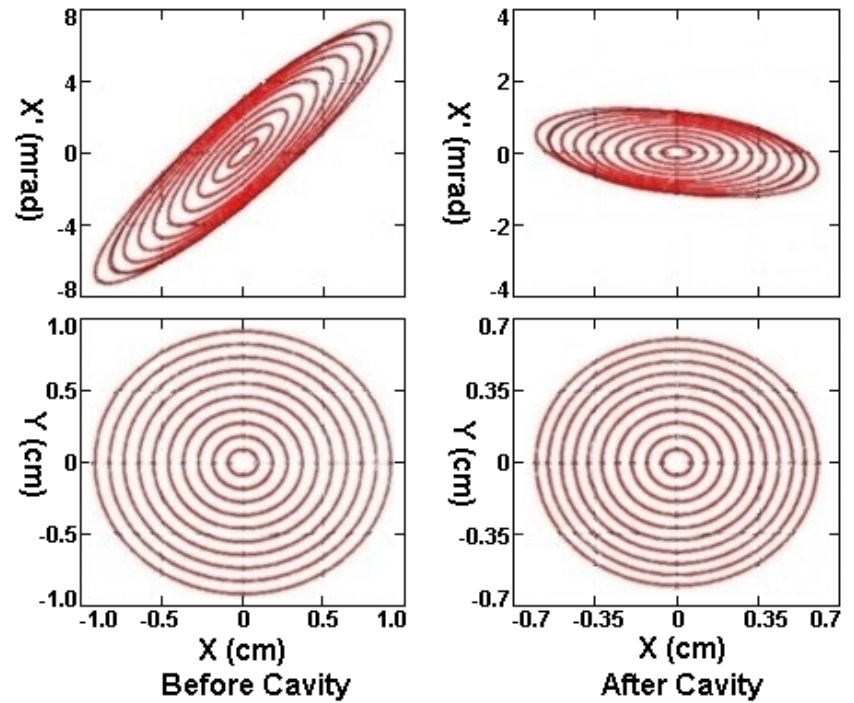
FIG. 2. (Color) Phase space structure before and after 9-cell rf